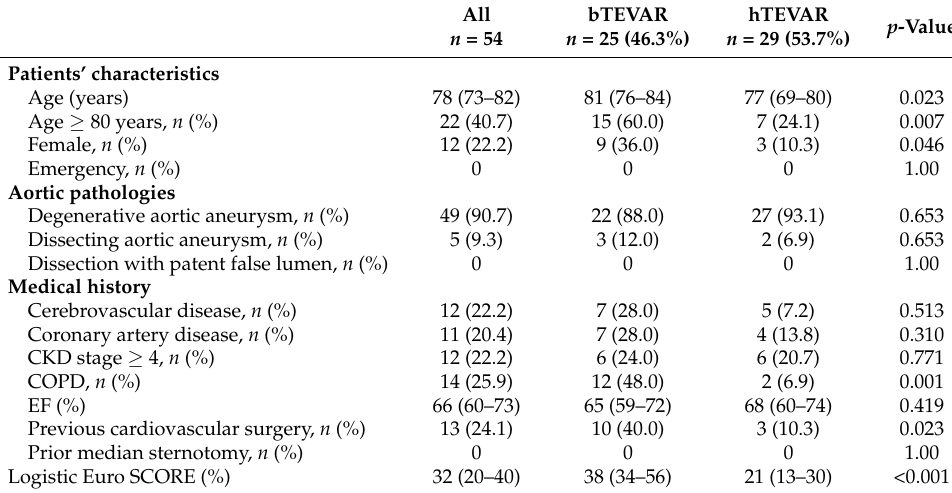
Table 1. Patients’ characteristics and preoperative measurements.